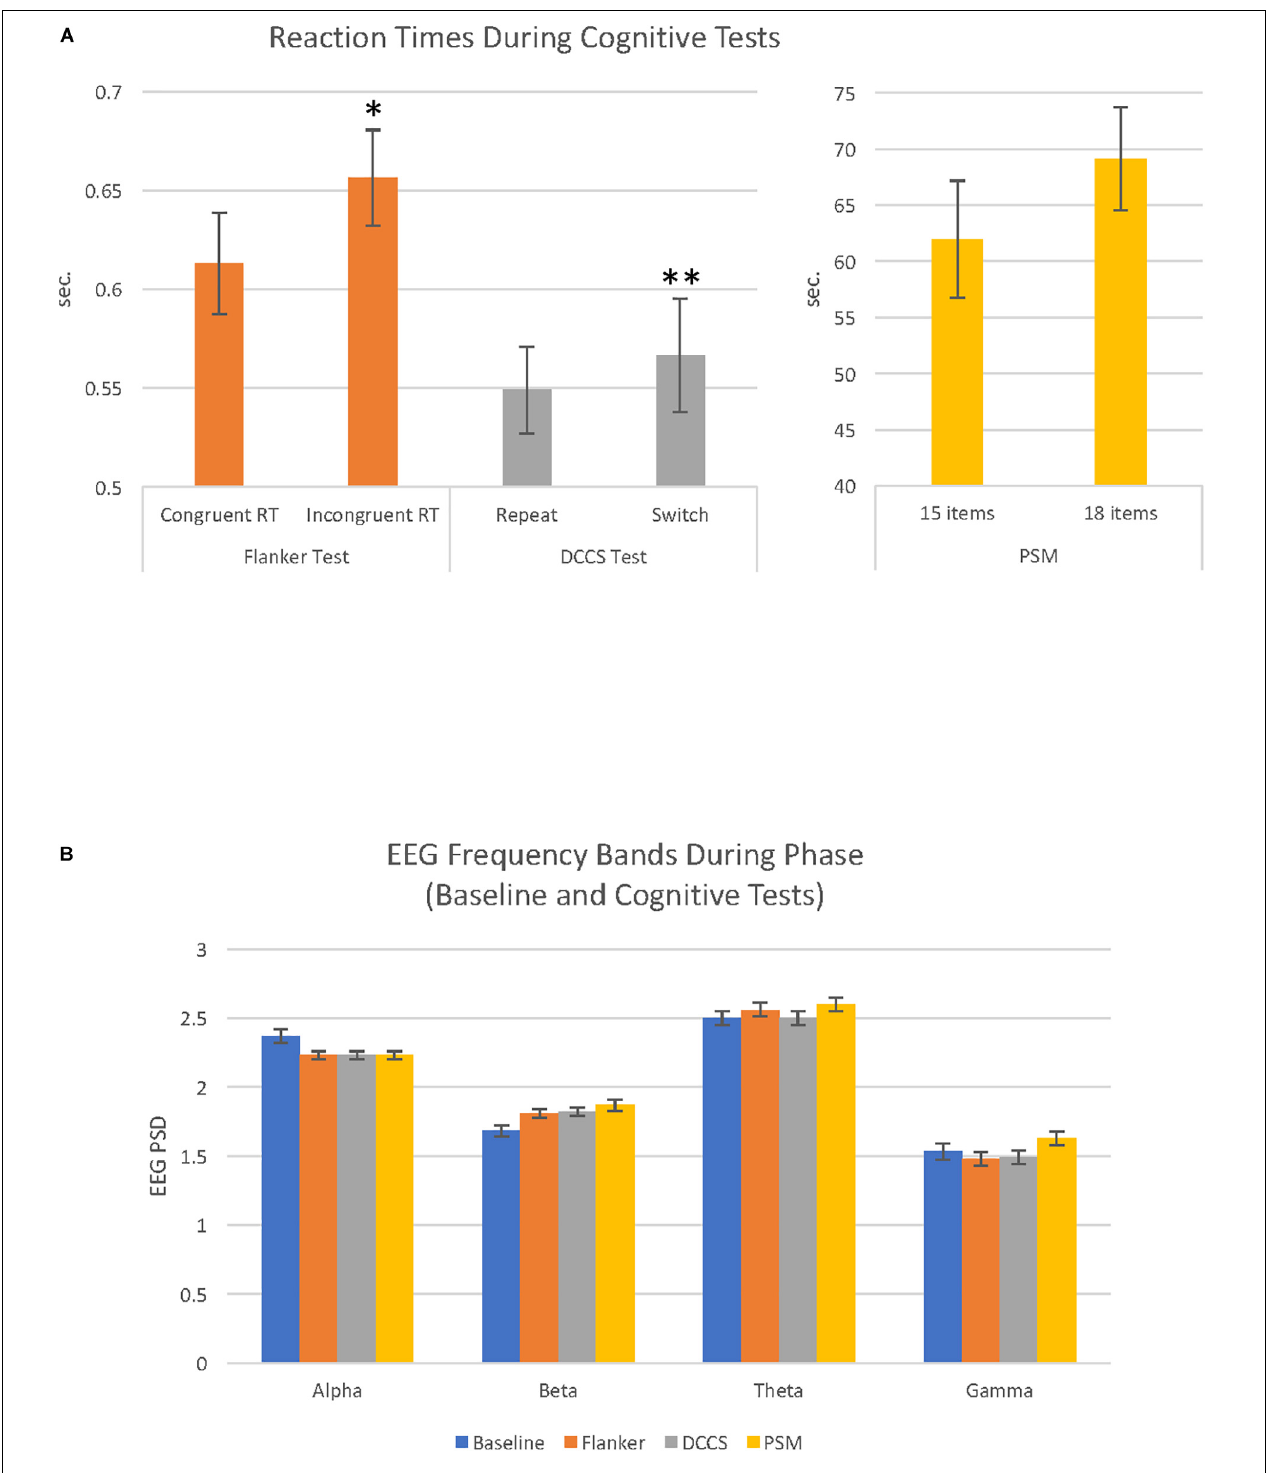
FIGURE 1 | Cognitive test reaction times and EEG activity recorded during baseline and cognitive test conditions. (A) Bar graphs illustrate reaction times (RT) during the 3 cognitive tests (Flanker, DCCS and PSM). Each cognitive test had 2 conditions that were evaluated in paired-samples t -tests; for the Flanker test, congruent reaction time (RT) vs. incongruent RT; for the DCCS test, repeat vs. switch; for the PSM test, trial 1 (15 items) vs. trial 2 (18 items). These comparisons were significantly different in the Flanker ( ∗ p < 0.05) and DCCS ( ∗∗ p < 0.01). (B) bar graphs illustrate EEG power spectral density (PSD) for alpha, beta, theta and gamma EEG frequency bands recorded during baseline (eyes open resting state), and the 3 cognitive tests (Flanker, DCCS, PSM). Alpha and theta PSD were higher compared to beta and gamma during the cognitive tests and baseline (all comparisons p = 0.0001). For details of other significant differences (see Table 1 ).